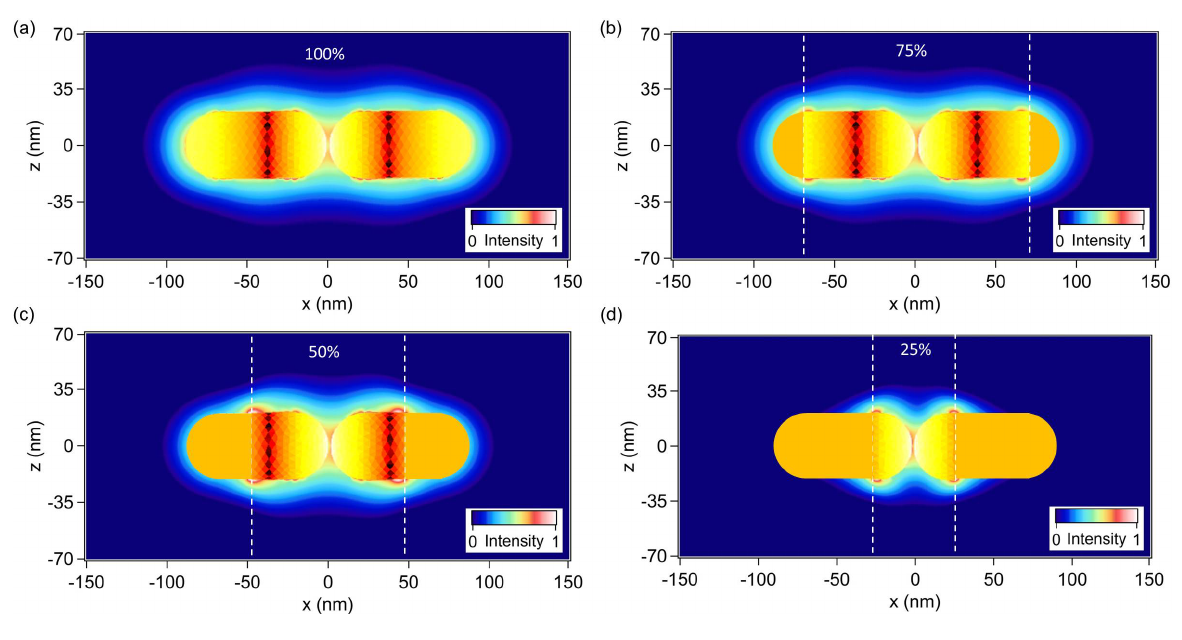
Figure 4: Normalized near-field distributions of the second harmonic electric field intensity close to the gold nanodimer with a gap g = 5 nm evaluated (a) for the entire surface nonlinear polarization and for (b–d) partial surface nonlinear polarizations. The percentages indicate the ratio between the length over which the surface nonlinear polarization is maintained and the total length of the nanorod. For example, 50% indicates that only half of the surface nonlinear polarization is considered as shown in panel (c). The same color scale is used for all the panels.